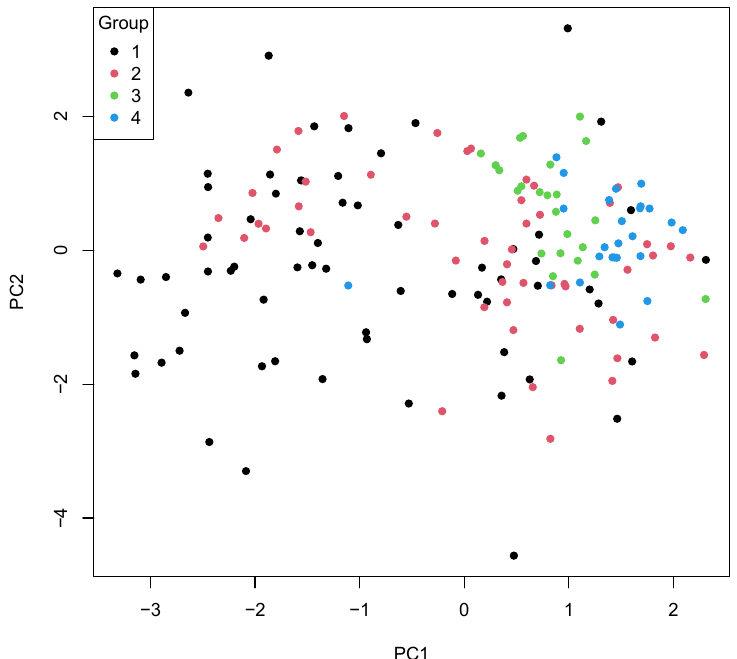
Figure 2. Principal component analysis (PCA) of all investigated parameters. Group 1 (black dots) = severe multiple trauma; group 2 (red dots) = moderate multiple trauma; group 3 (green dots) = femur neck fracture; group 4 (blue dots) = ankle fracture.